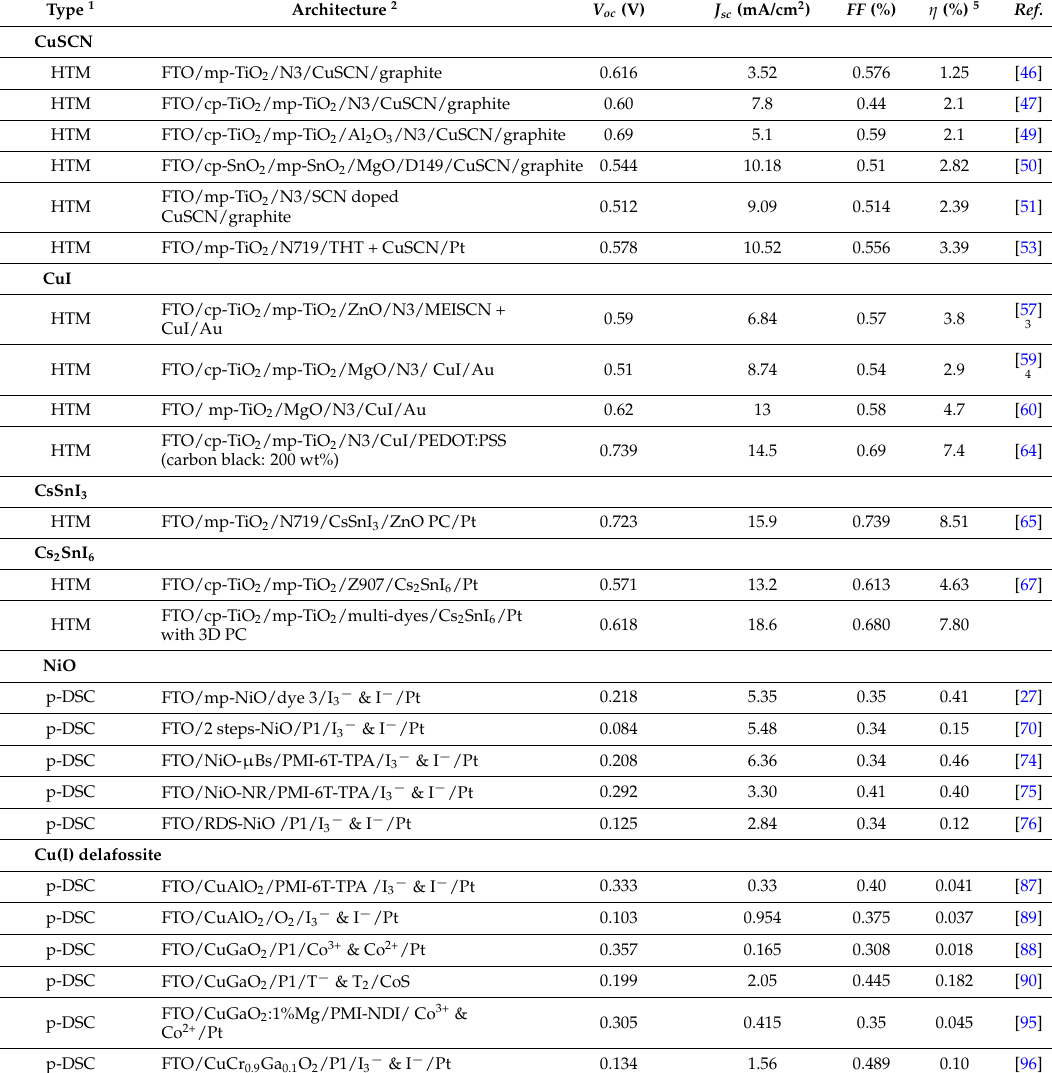
Table 1. Summary of photovoltaic characteristics of dye-sensitized solar cells (DSCs) based on p-type inorganic solar cells